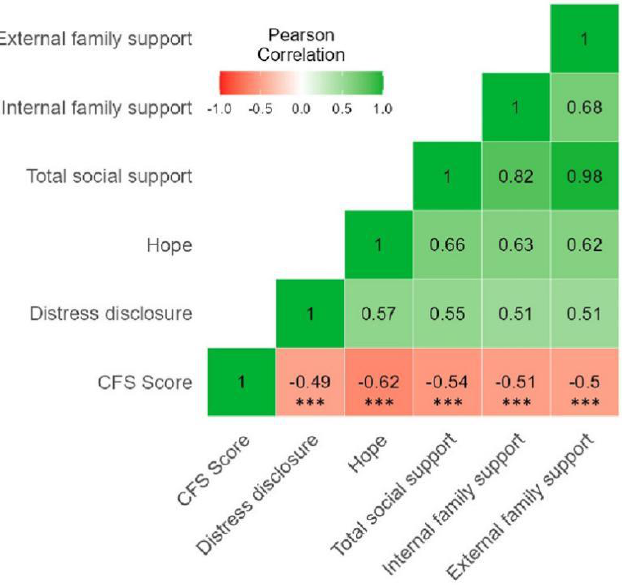
Figure 3. Correlations between CFS score and other psychosocial variables: a correlation heatmap. Notes: CFS, cancer fatigue scale; The number in the box □ represents Pearson’s correlation coefficient, positive number represents positive correlation, and negative number represents negative correlation; *** p < 0.001.